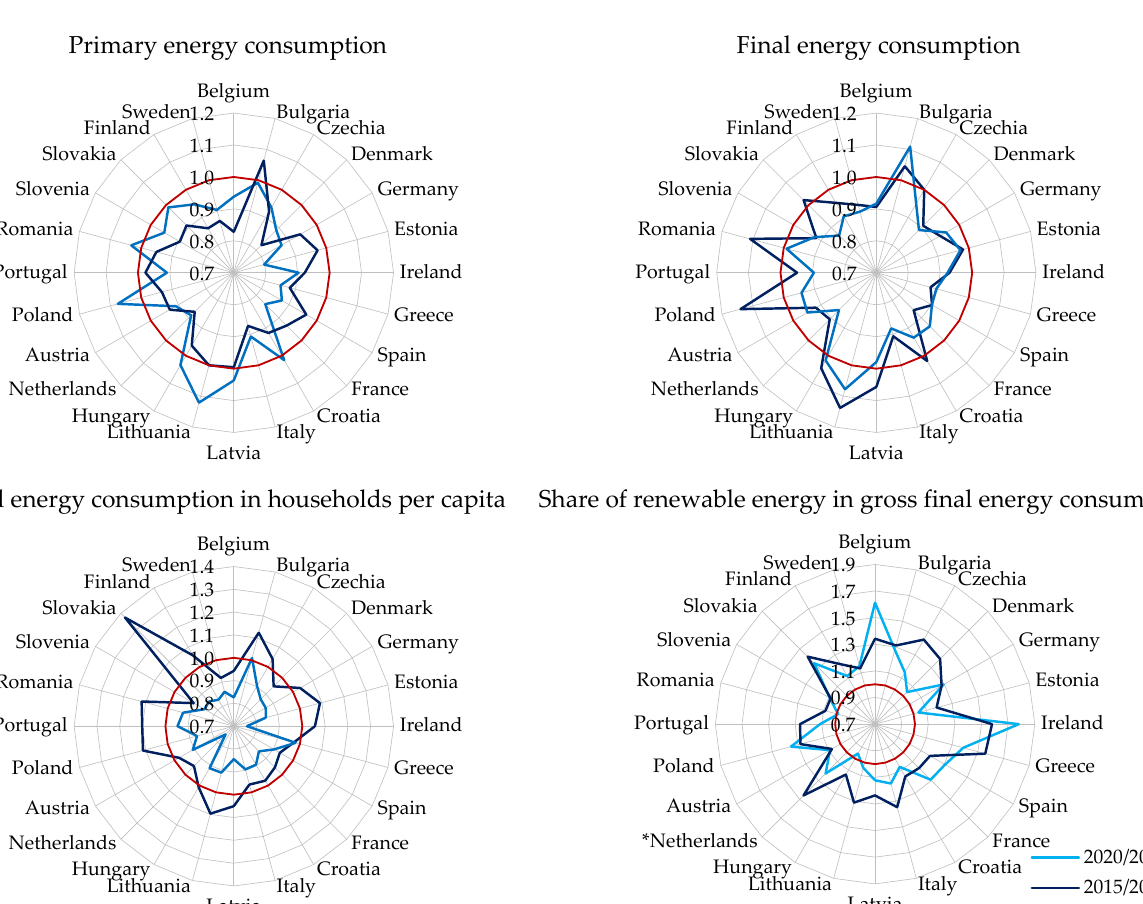
13 of 20 Table 5. Numerical characteristics of sustainable energy development indicators in specific years. Variable